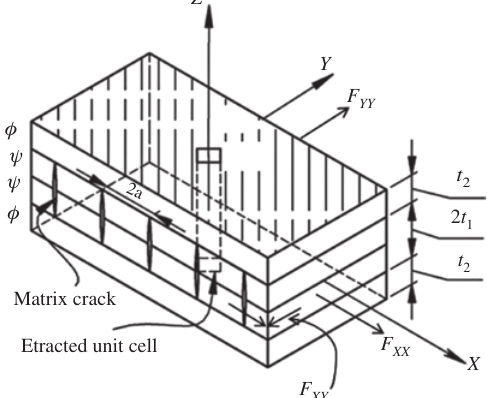
Figure 1: Geometry of a symmetric laminate containing cracks in the middle layers in a global coordinate